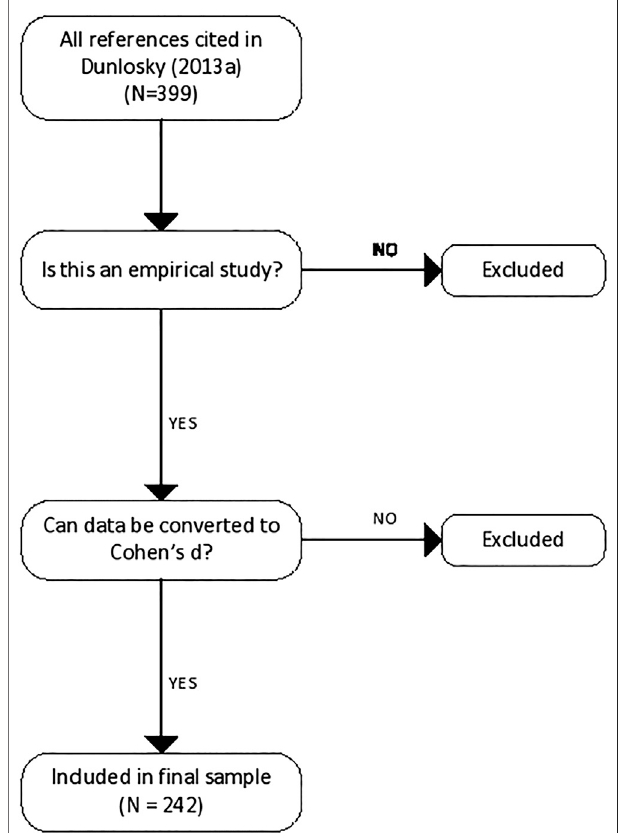
FIGURE 1 | Flow diagram of articles used in the